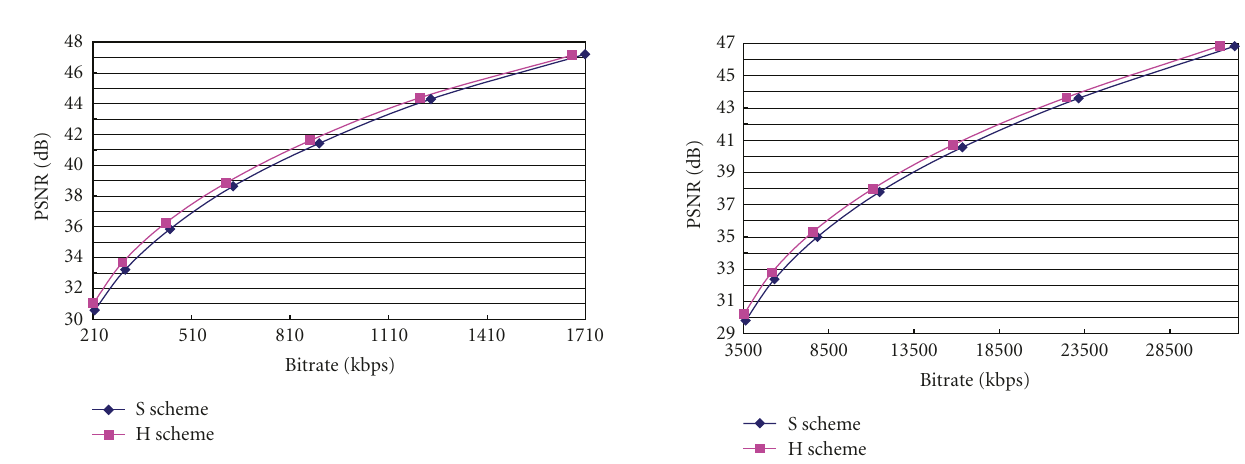
Figure 8: RD curves of encoding Harbor (4CIF) sequence with S scheme and H